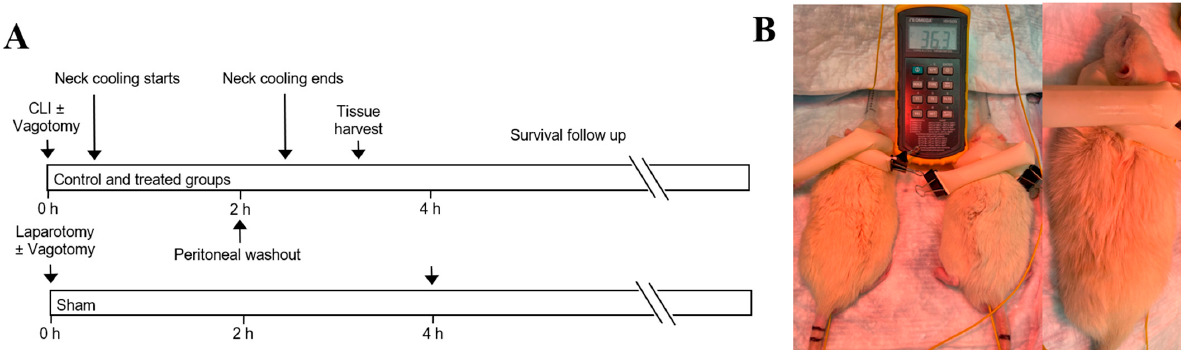
Figure 2. ( A ) Experimental protocol. ( B ) Topical neck cooling with ice-filled Penrose. CLI: cecal ligation and incision .